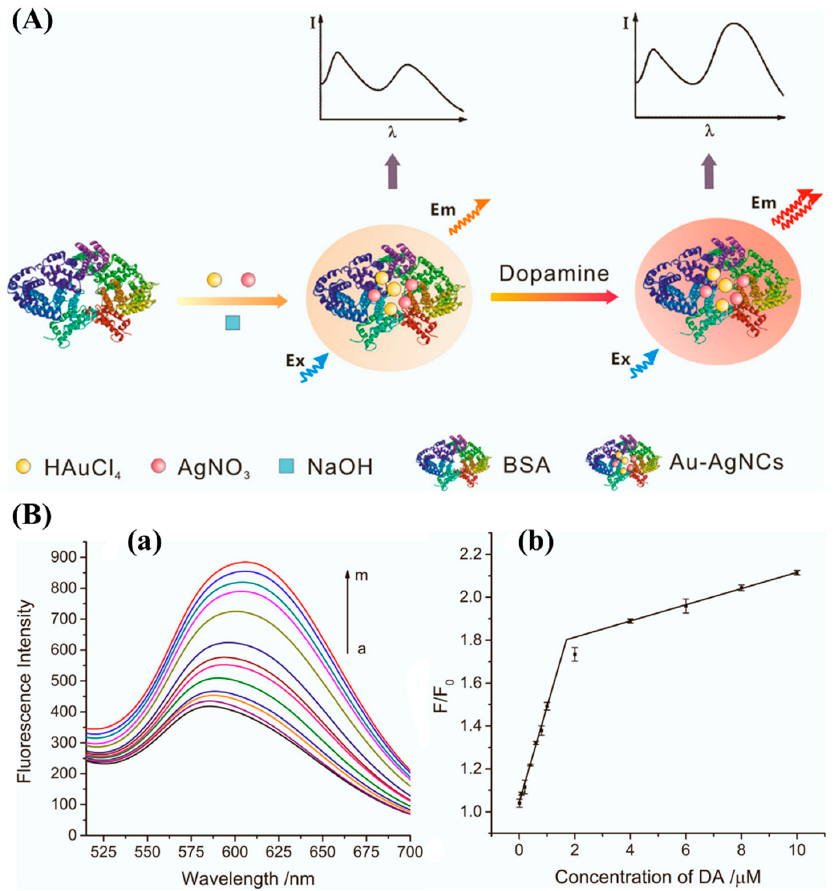
Figure 4. ( A ) Schematic diagram of bimetal Au-Ag nanocluster-based fluorescence detection of dopamine. ( B ) (a) Fluorescence intensity-correlated different concentrations of dopamine samples at 0, 0.01, 0.08, 0.2, 0.4, 0.6, 0.8, 1, 2, 4, 6, 8, and 10 μ M labeled from “a” to “m”. (b) A linear curve of fluorescence intensities correlated with the concentrations of dopamine at pH 8.5 Tris-HCl buffer. Fluorescence measurements under 370 nm excitation after 15 min incubations. Adapted from [84].